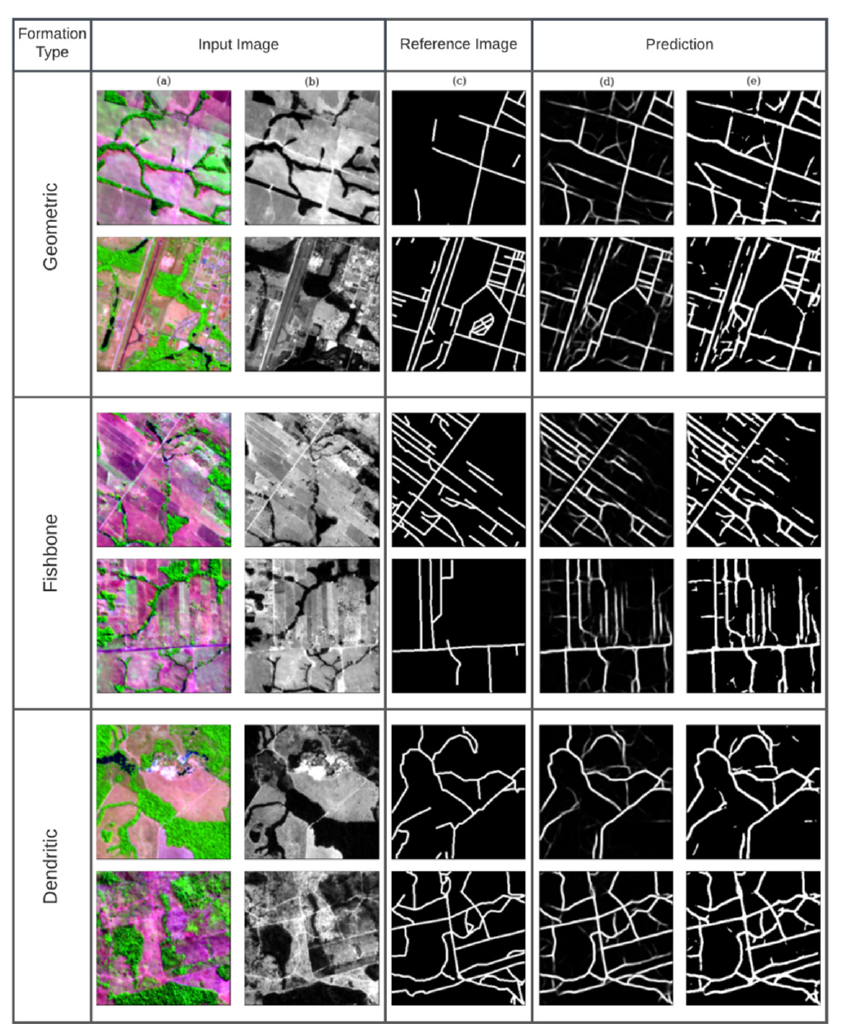
Figure 7. Comparison between the reference data and the predicted roads with the U-Net model. ( a ) RGB (SWIR1, NIR, and Red) Sentinel-2 input image for road prediction. ( b ) Grey level Sentinel-2 Red band for better visualization of roads. ( c ) Manually mapped reference data. ( d ) Raw road prediction result. ( e ) Filtered result with more than 20% confidence used as input for the post- classification.